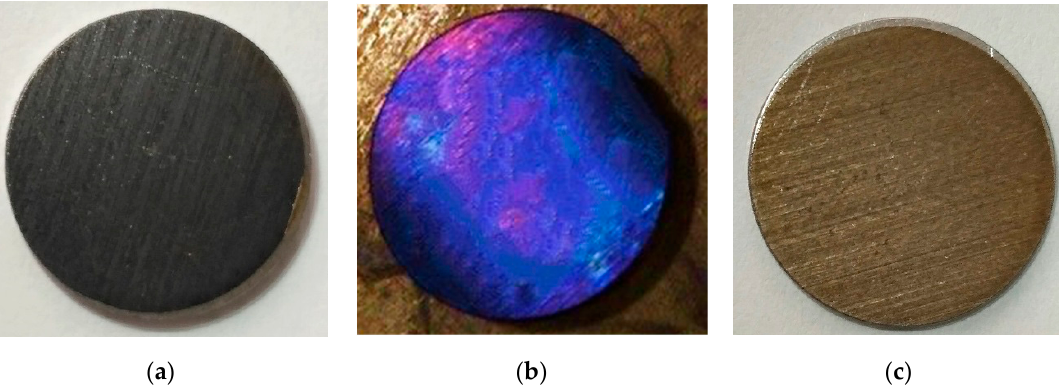
Figure 7. Colour shades on the steel surface after laser treatment: ( a ) black; ( b ) blue; ( c ) gold.